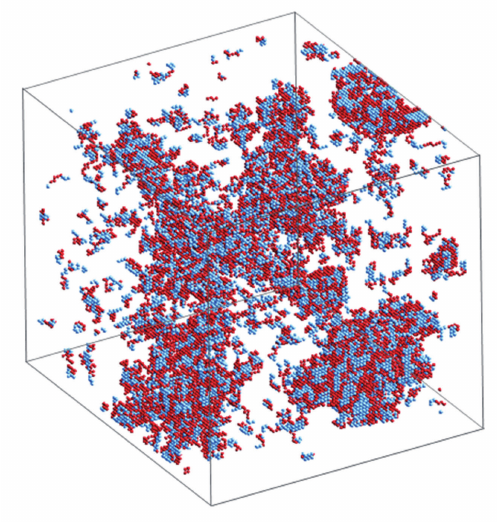
F 15: Snapshot of box of simulation of (H fraction of